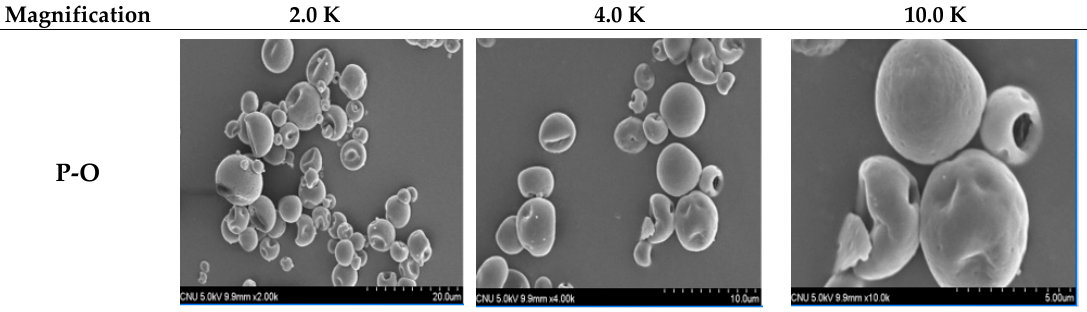
Figure 3. The SEM image of spray-dried omega-3 powder using γ -CD and hydrogenated lecithin with the optimal spray drying condition.